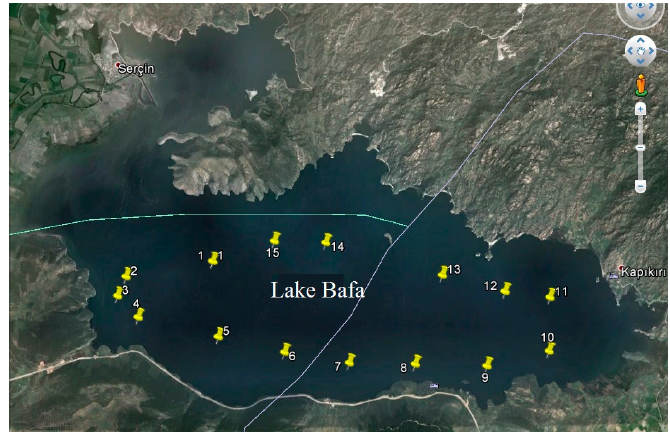
Figure 2. Sampling points of surface sediments [8].